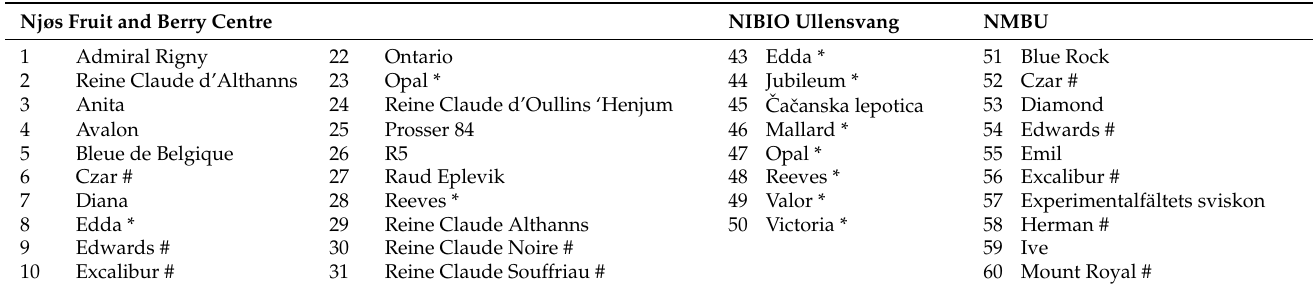
Table 1. Assigned samples of 68 Norwegian plum cultivars from Njøs Fruit and Berry Centre (42 sam- ples) and from the Norwegian Institute of Bioeconomy Research-NIBIO Ullensvang (8 samples) collected in 2019 and 2021, and from the Norwegian University of Life Sciences-NMBU (18 samples) collected in 2019 and